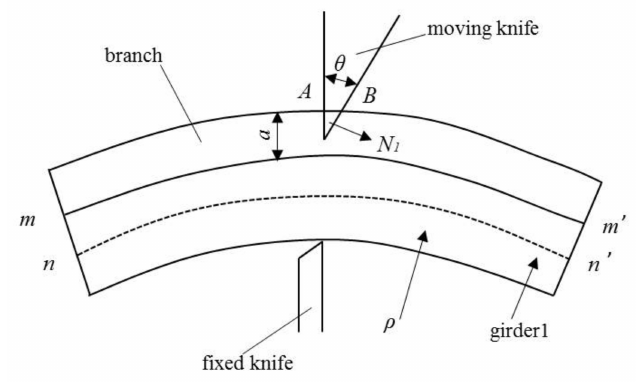
Figure 14. Beam bend under the action of the extruding force of the moving